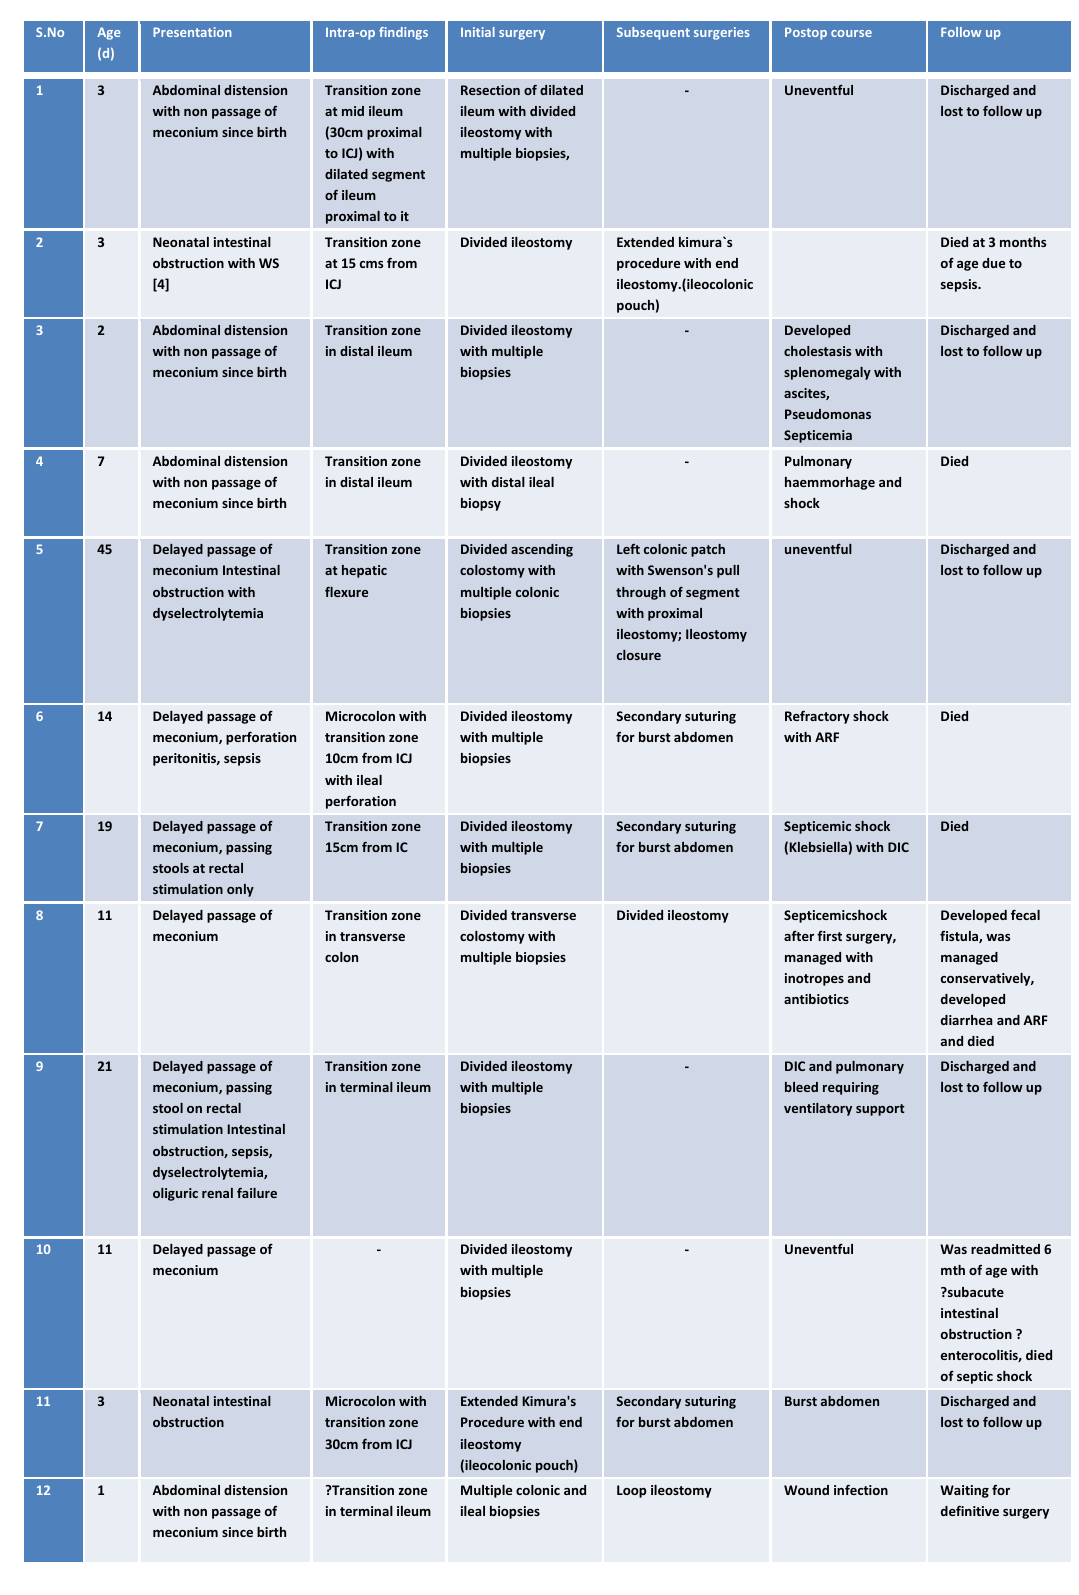
Table 1: Patient characteristics, surgical details and the